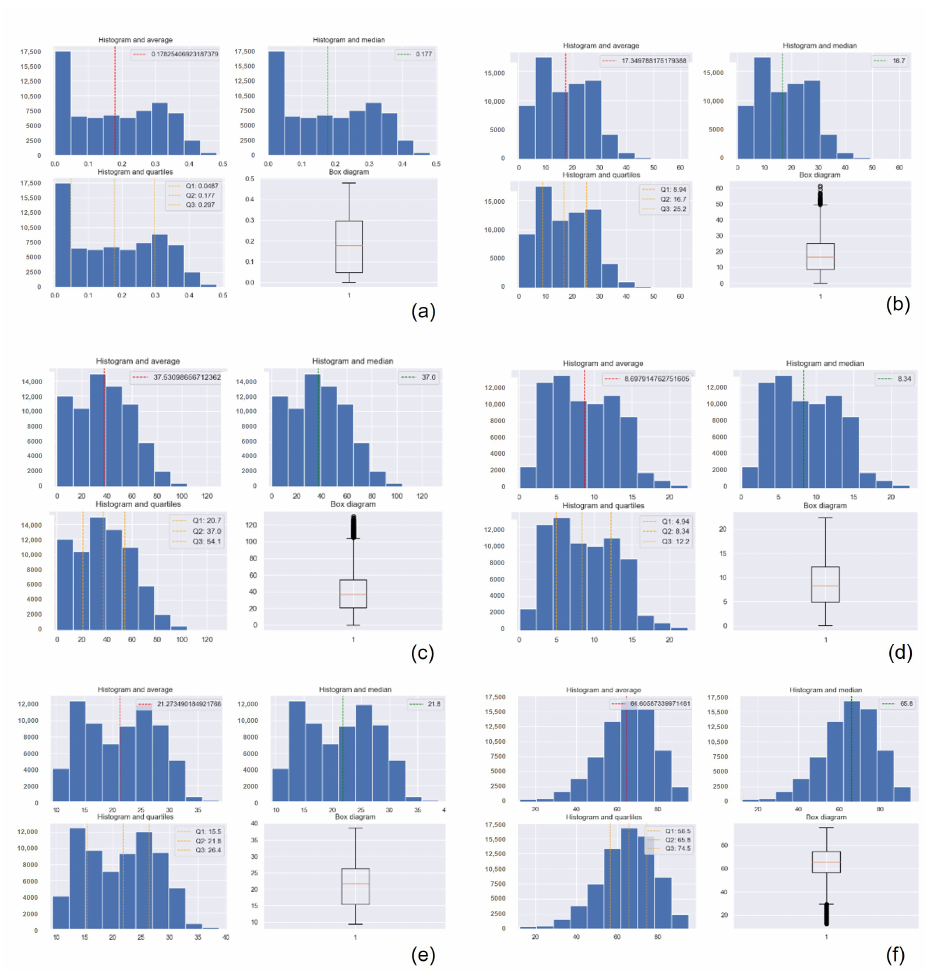
Figure A1. Statistics for ( a ) CO ( b ) NO 2 ( c ) O 3 ( d ) SO 2 ( e ) Temperature and ( f ) Humidity for the polluting gas measuring